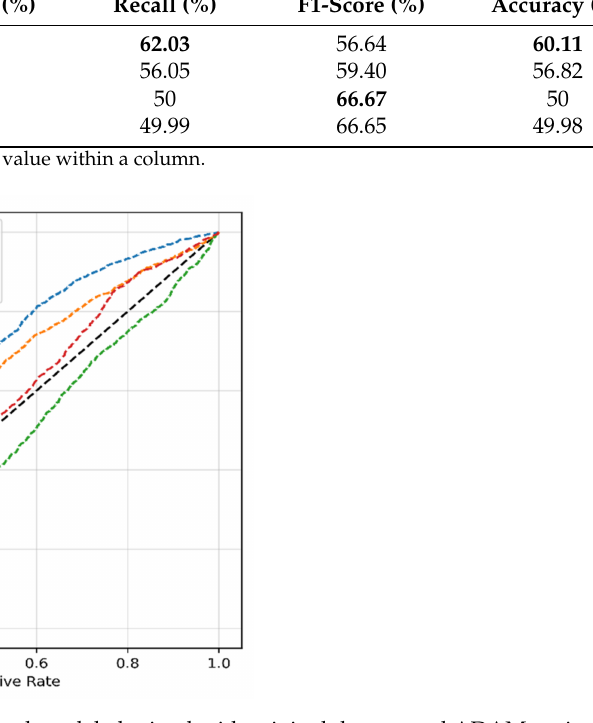
Figure 6. The ROCs of the proposed model obtained with original dataset and ADAM